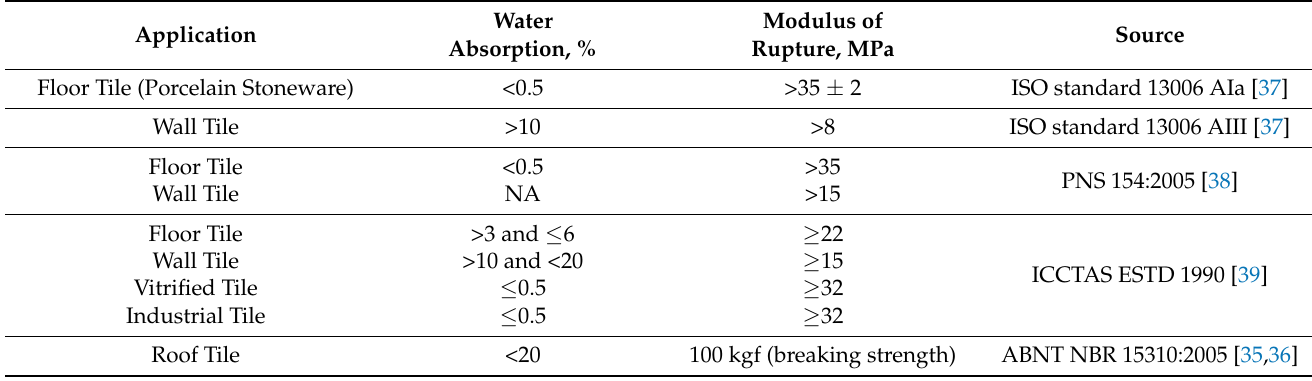
Table 4. Various Standard Requirements for Ceramic Tiles on Water Absorption and MOR.